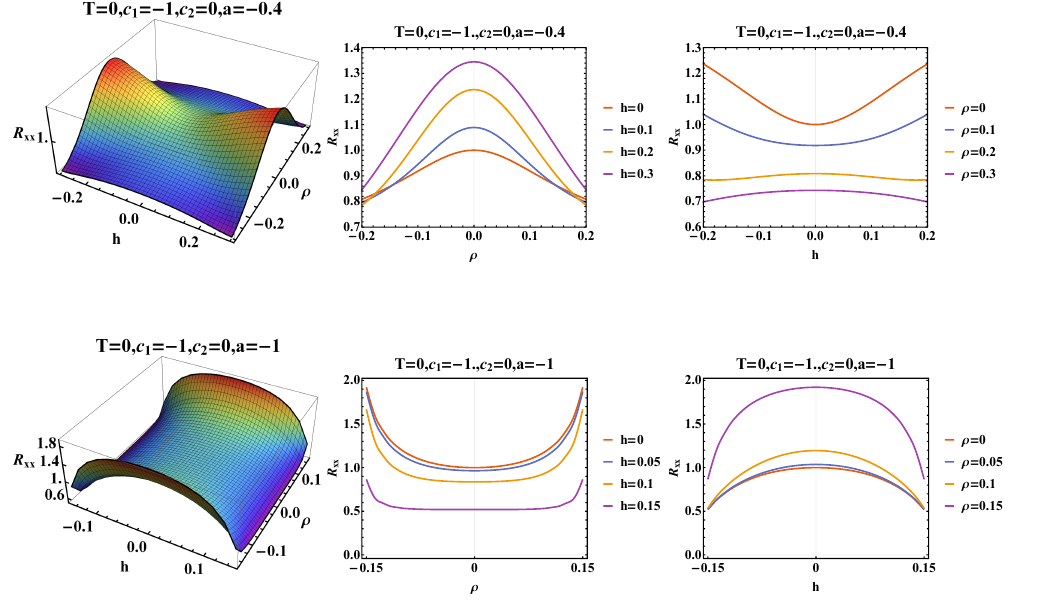
Figure 13 . R xy as a function of h and ρ and some intersection curves for fixed h and ρ for a = − 0 . 4 (upper panel) and a = − 1 (lower